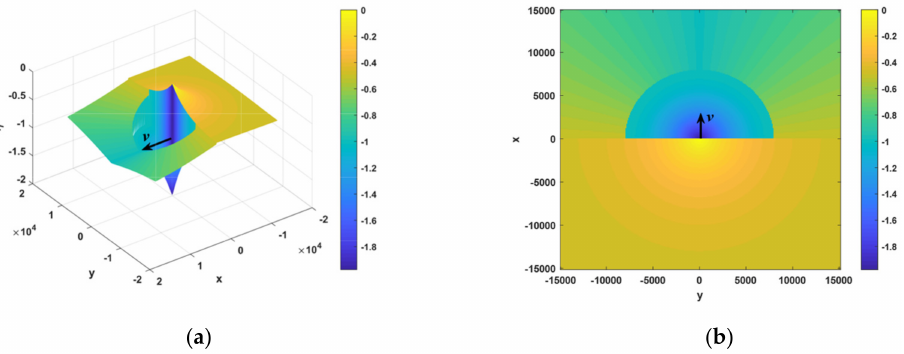
Figure 9. Air combat situation at the same altitude: ( a ) stereoscopic view of the air combat situation at the same altitude; ( b ) plan view of the air combat situation at the same